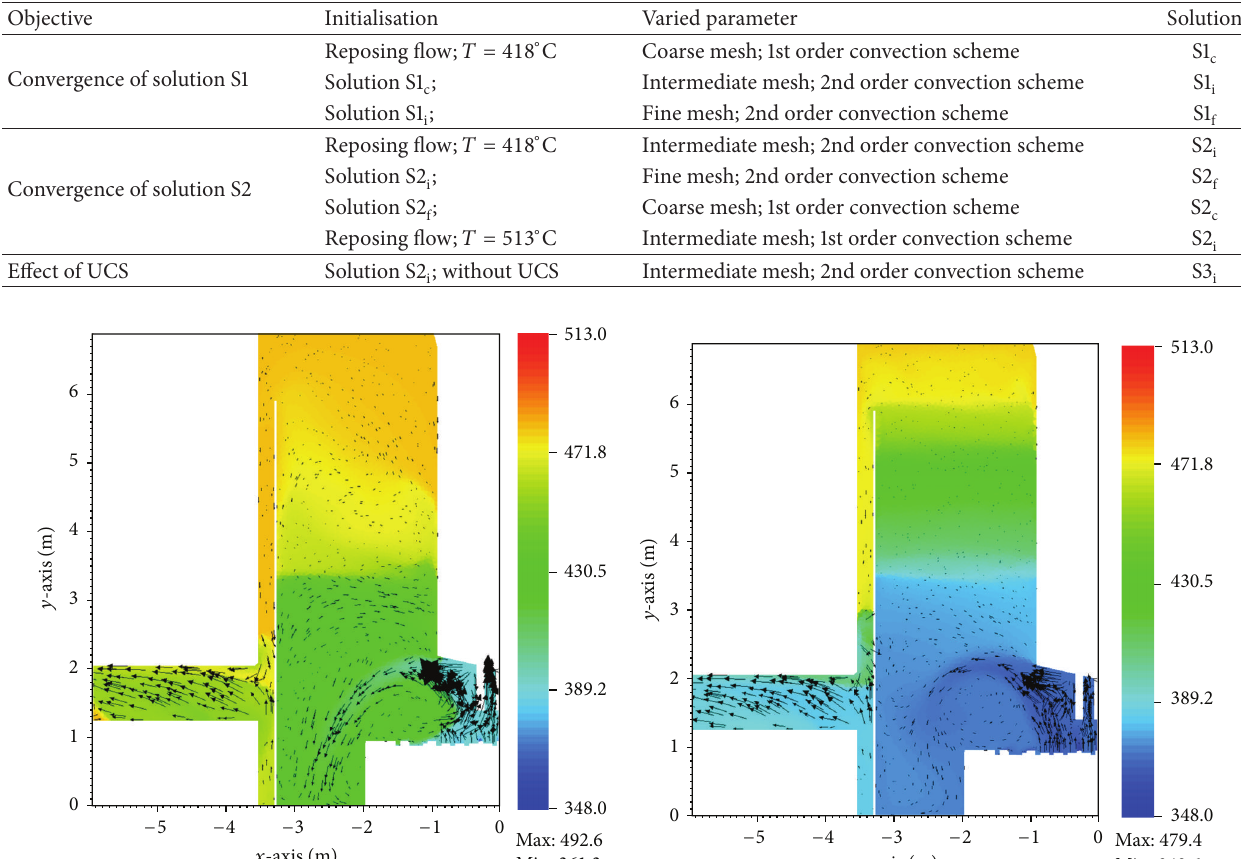
Table 5: Influence of varied parameters on the solution.